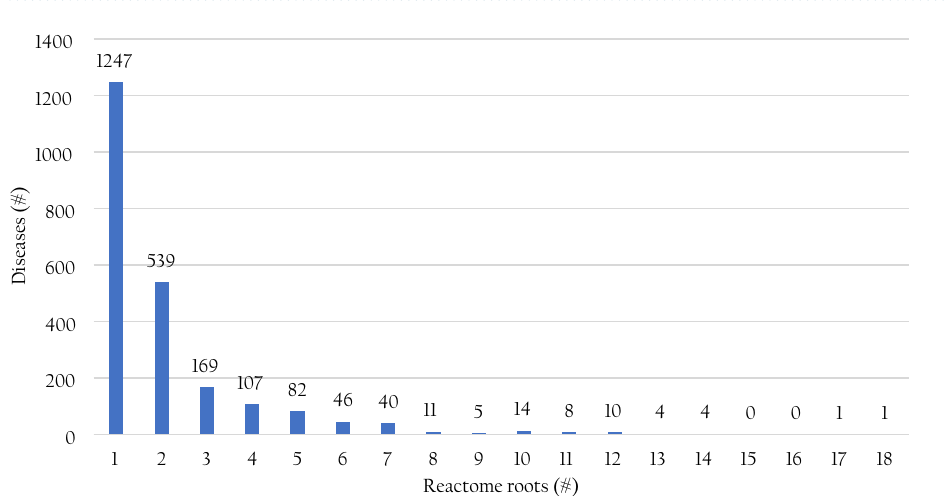
Figure 6. Distribution of diseases with respect to the Reactome roots they are associated with. #: number of. The number of enzymes in each group is reported at the top of each bar. The extreme cases are the colorectal cancer (Mondo: 0005575) and the hereditary breast carcinoma (Mondo:0016419) associated with 18 and 17 roots,